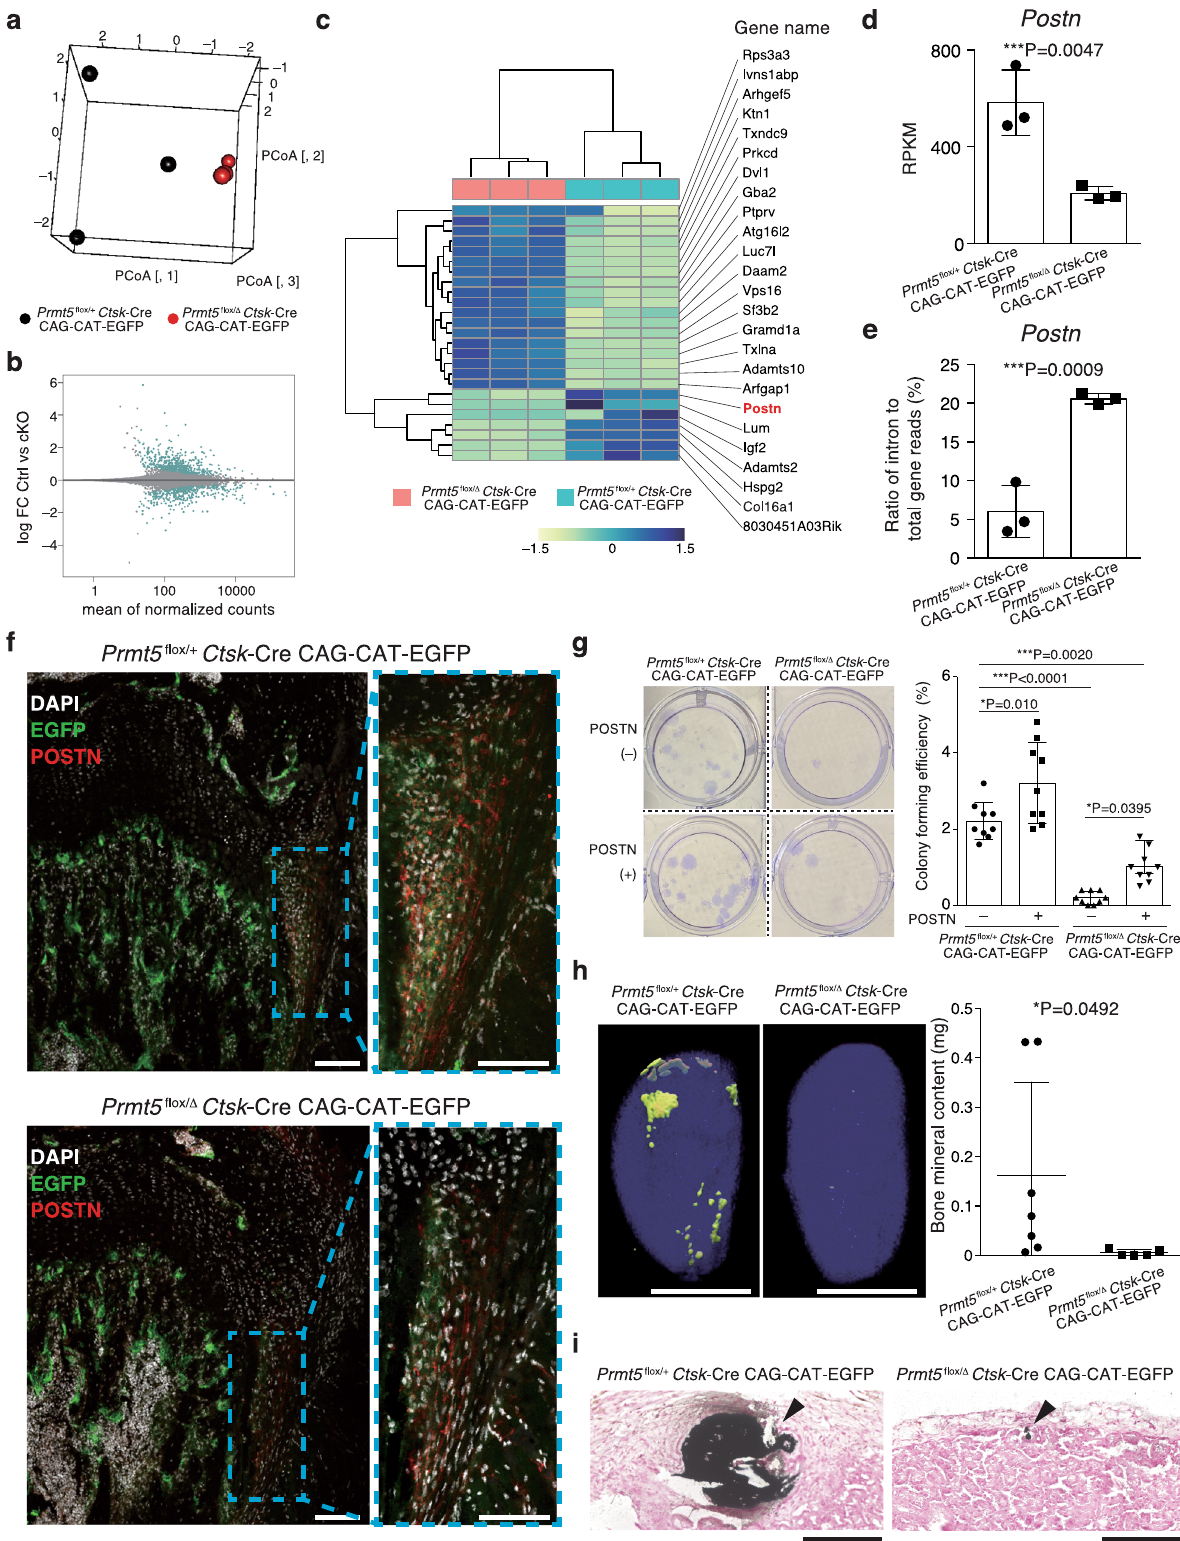
We therefore crossed Ihh fl ox/ fl ox mice 7 with Ctsk -Cre mice to investigate the physiological relevance of Ihh produced by PSCs. In Ihh fl ox/ fl ox Ctsk -Cre CAG-CAT-EGFP mice, the expression levels of Ihh decreased speci fi cally in PSCs, but not in the growth plate chondrocytes, periosteal CD90 + mature osteogenic cells or